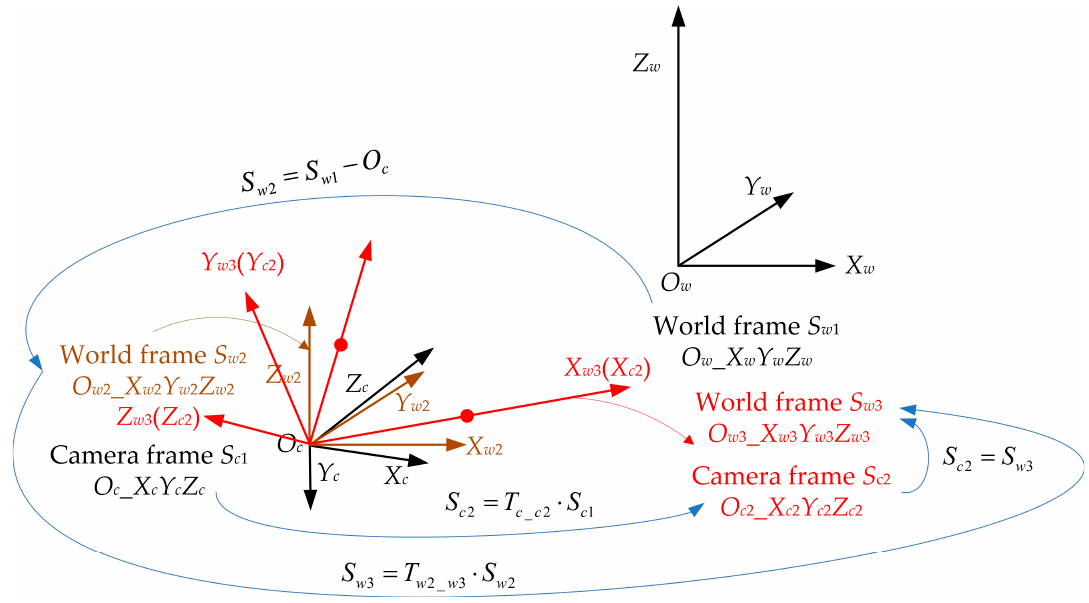
Figure 5. Transformations between di ff erent frames.